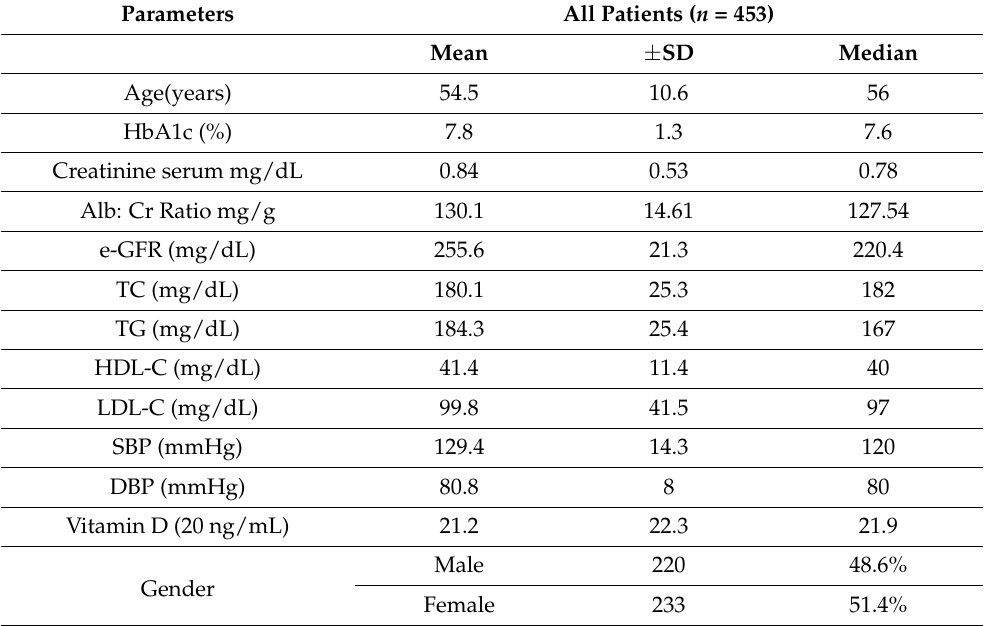
Table 1. Anthropometric and biochemical profile parameters results for patients with T2DM. Parameters